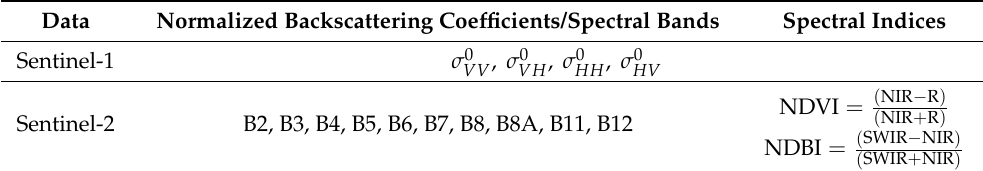
Table 2. The normalized backscattering coefficients, spectral bands, and indices used in this study (NDVI = Normalized Difference Vegetation Index, NDBI = Normalized Difference Build-up Index). Data Normalized Backscattering Coefficients/Spectral Bands Spectral Indices Sentinel-1